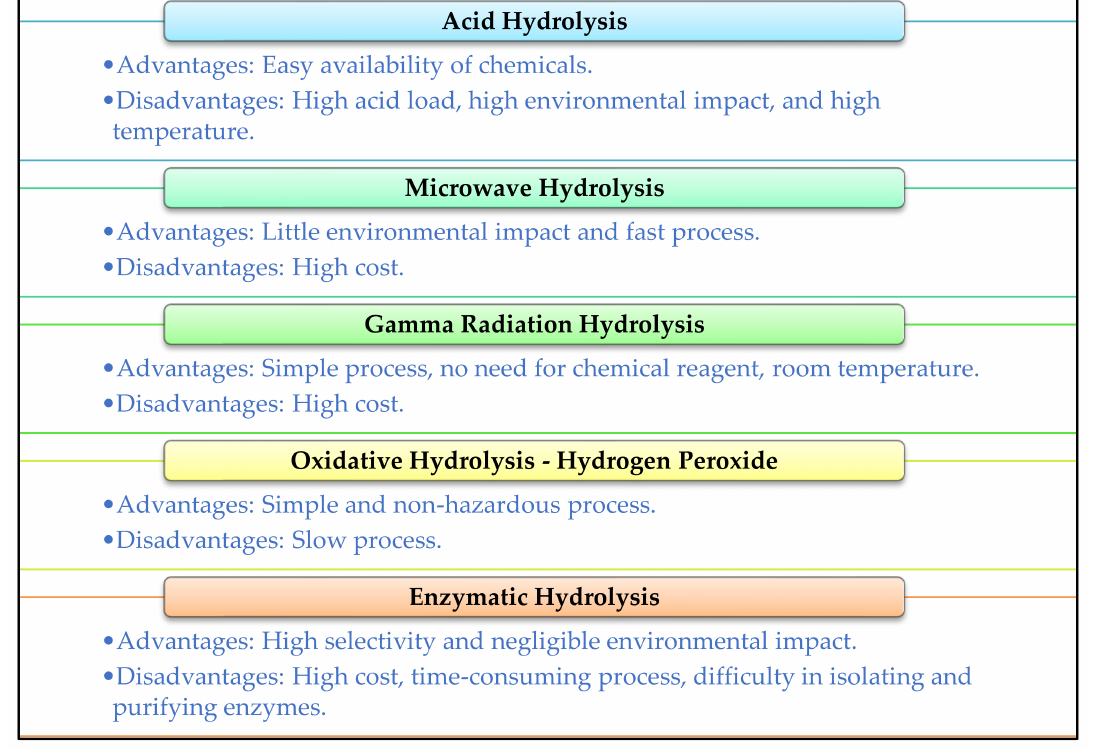
Figure 2. Advantages and disadvantages of the main chitosan hydrolysis